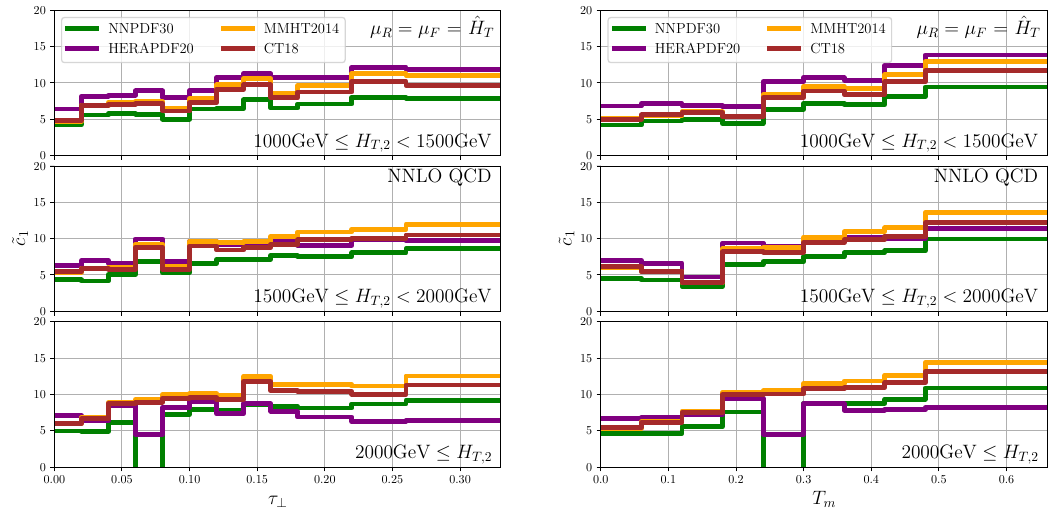
Figure 7 . The transverse thrust τ ⊥ (left) and the thrust minor T m (right) in three H T, 2 bins. The solid lines show the coefficient ˜ c at NNLO QCD for different PDF sets. 1